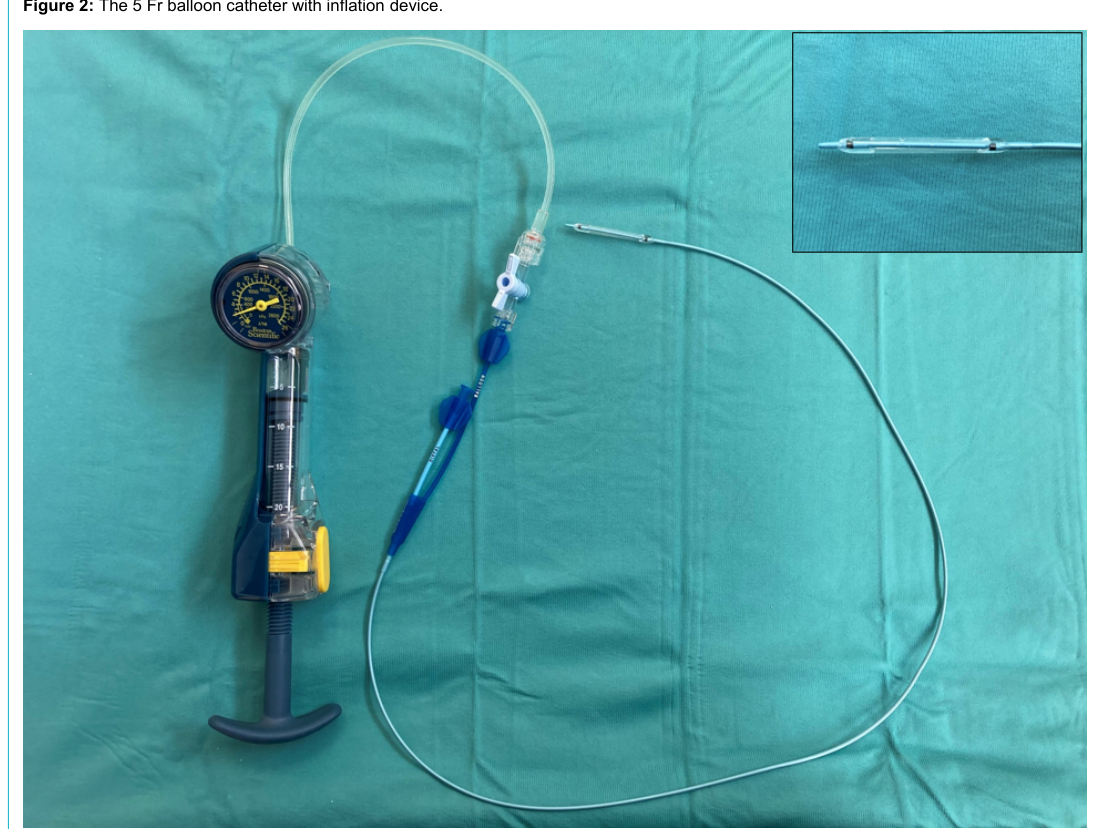
Figure 2: The 5 Fr balloon catheter with inflation